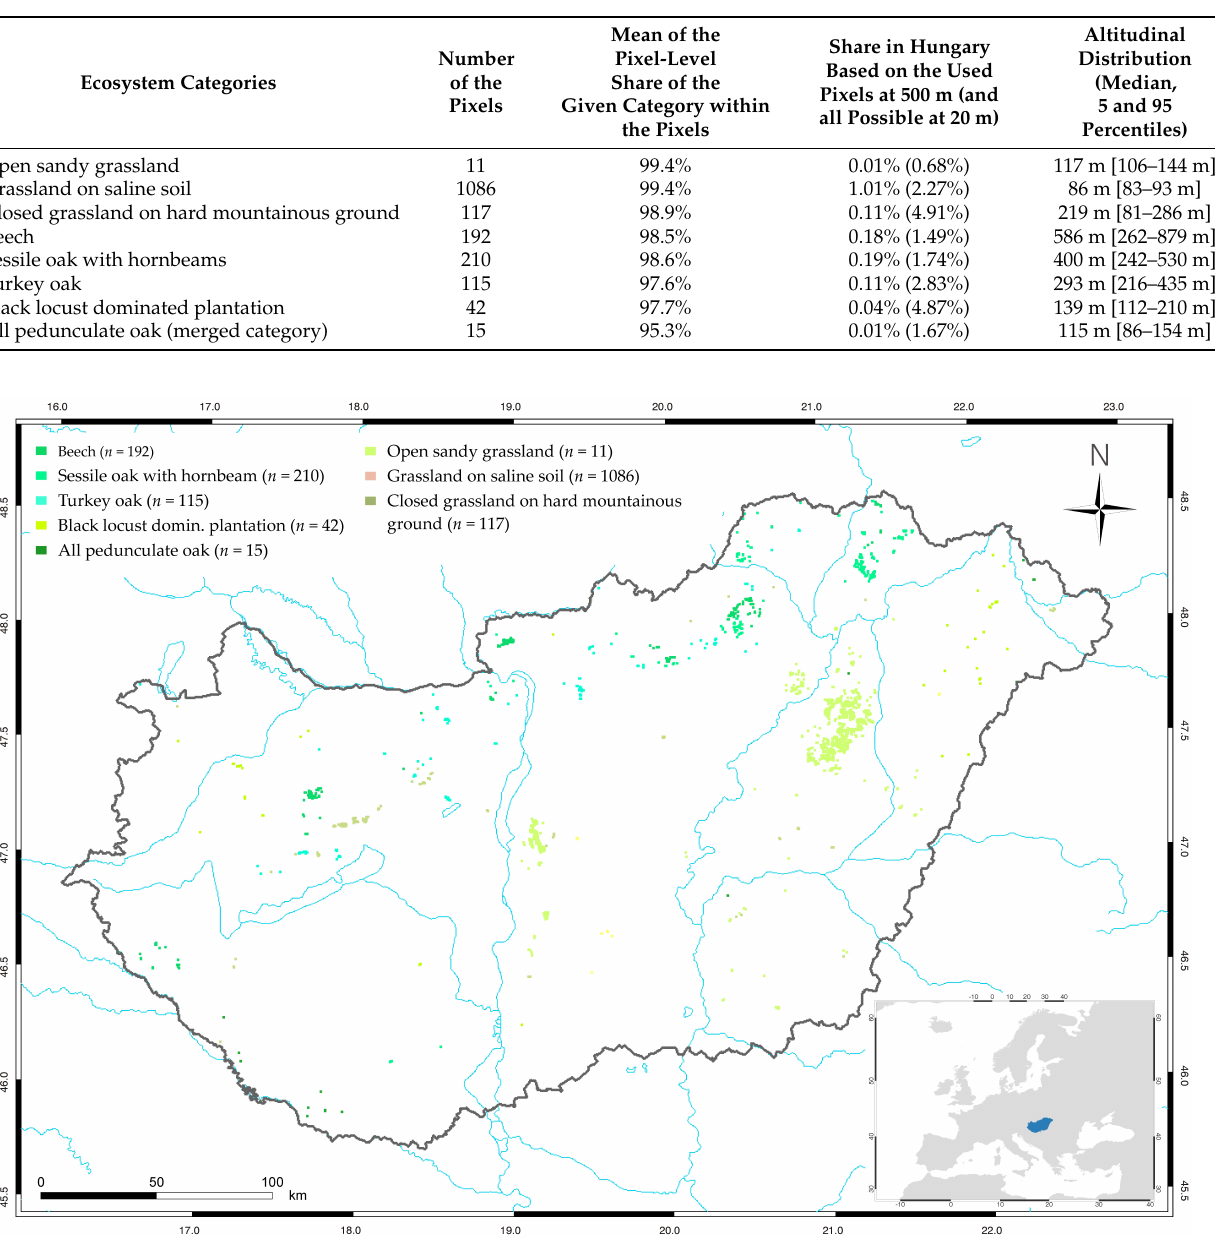
Table 1. Spatial, areal, and altitudinal descriptive statistics of the selected HKM MODIS pixels regarding the different ecosystem categories of the NÖSZT É P dataset. The “total native share” gives information about the total presence of the given ecosystem category within Hungary based on the native resolution of the LC dataset (at 20 × 20 m).